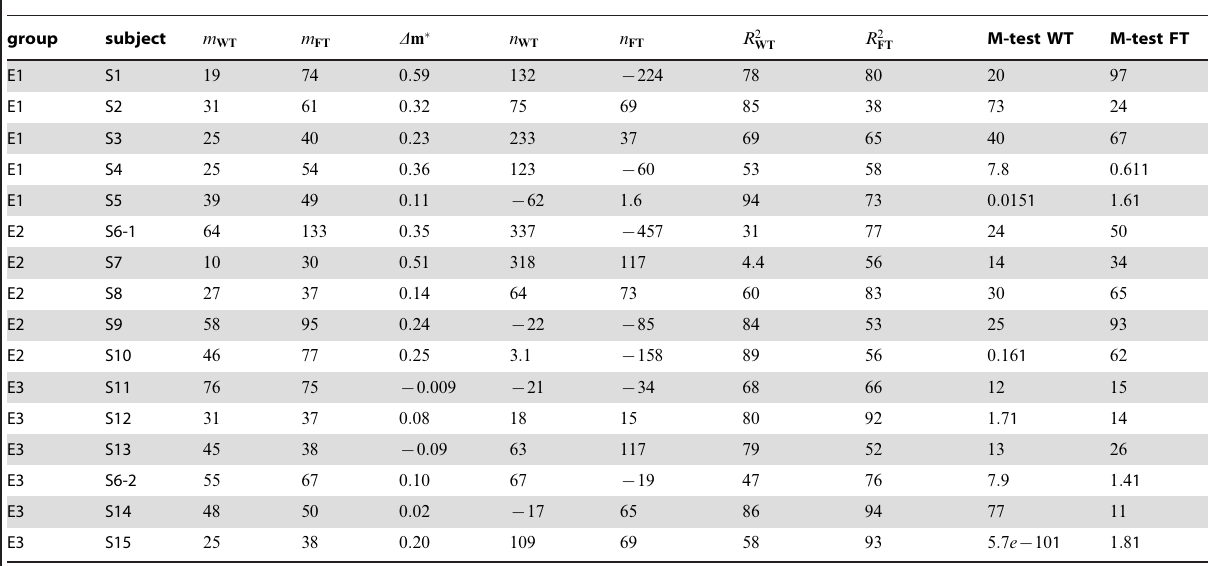
Table 2. Linear regression and Mandels test for